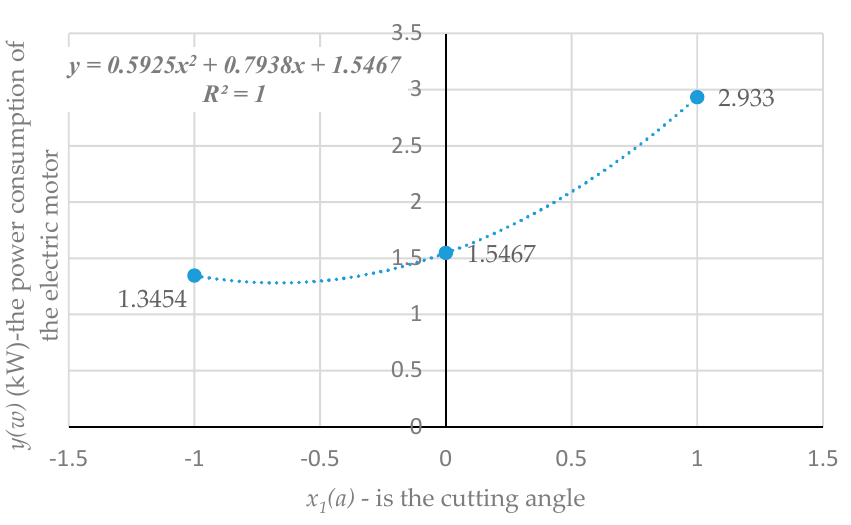
Figure 9. Graphical interpretation of the dependence of the power consumption of the branch chopper y ( w ) on the cutting angle x 1 ( a )